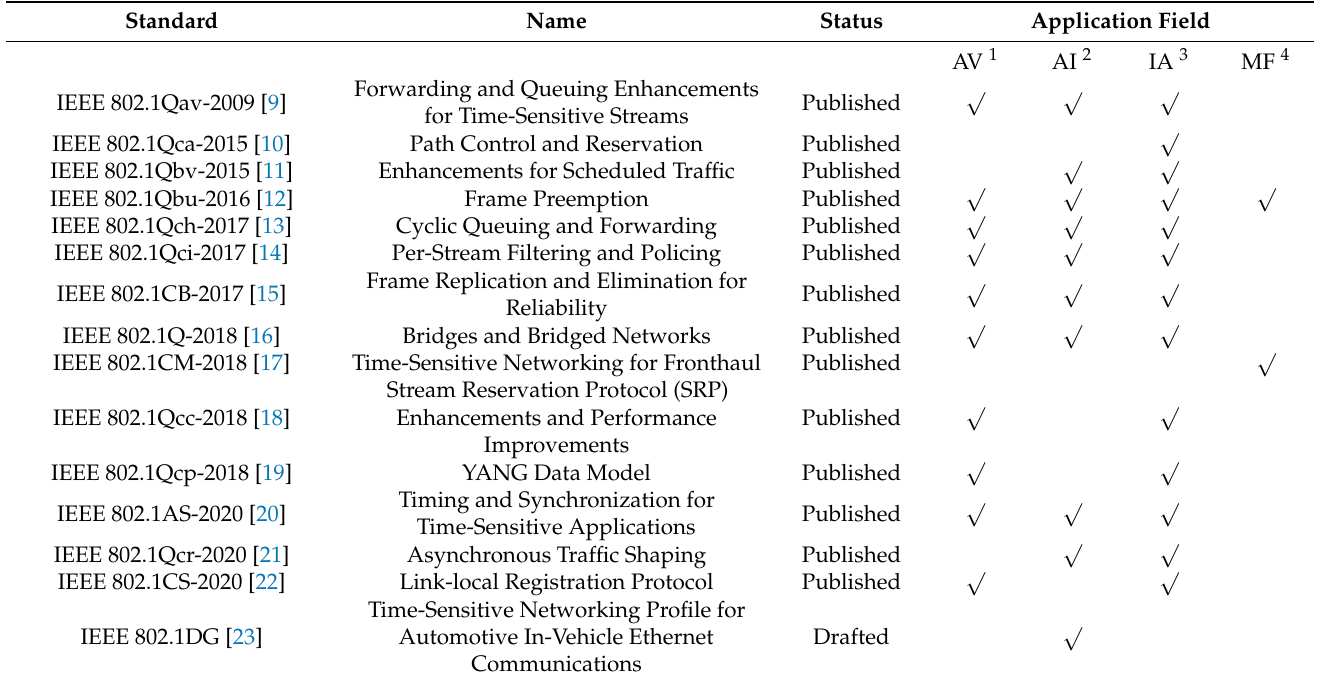
Table 1. Development status of TSN